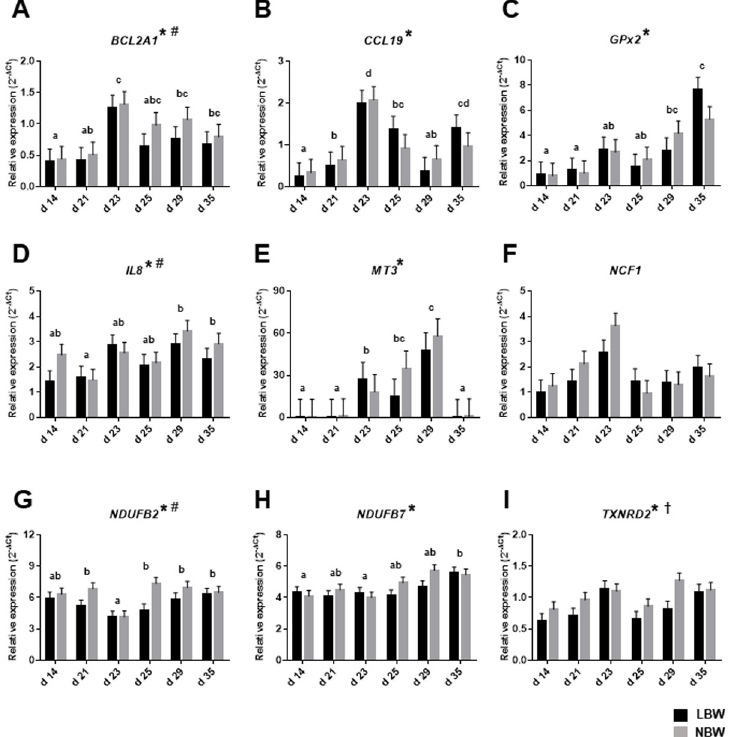
Fig 2. Relative mRNA levels of BCL2A1 , CCL19 , GPx2 , IL8 , MT3 , NCF1 , NDUFB2 , NDUFB7 and TXNRD2 were analyzed in mucosa of the jejunum of from the two experimental groups of piglets from different ages throughout the peri-weaning period. Bars in the graphs represent least-square means ± SEM of 10 piglets. Asterisk ( � ) indicates a significant effect of the age on means at P � 0.05. Dagger (†) indicates a significant effect of the birth weight on means at P � 0.05. In all cases, the interaction between age and birth weight is not significant P > 0.05. Pound (#) indicates that means tended to be affected by birth weight at P < 0.10. Detailed P-Values for main effects and interactions are available in S15 Table in S1 File and comparative analysis with litter and gender as random cofactors in S16 Table in S1 File and box plot of raw data distribution in S4 Fig in S1 File. Ages with different letters (a, b, c, d) within the graphs are statistically different at P � 0.05. LBW = low-birth weight piglets; NBW = normal-birth weight piglets; (A) BCL2A1 = B-cell lymphoma 2-related protein A1 (B) CCL19 = c-c motif chemokine ligand 19; (C) GPx2 = glutathione peroxidase 2; (D) IL8 = interleukin 8; (E) MT3 = metallothionein 3; (F) NCF1 = neutrophil cytosol factor 1; (G) NDUFB2 = NADH ubiquinone oxidoreductase subunit B2; (H) NDUFB7 = NADH ubiquinone oxidoreductase subunit B7; (I) TXNRD2 = thioredoxin reductase 2.